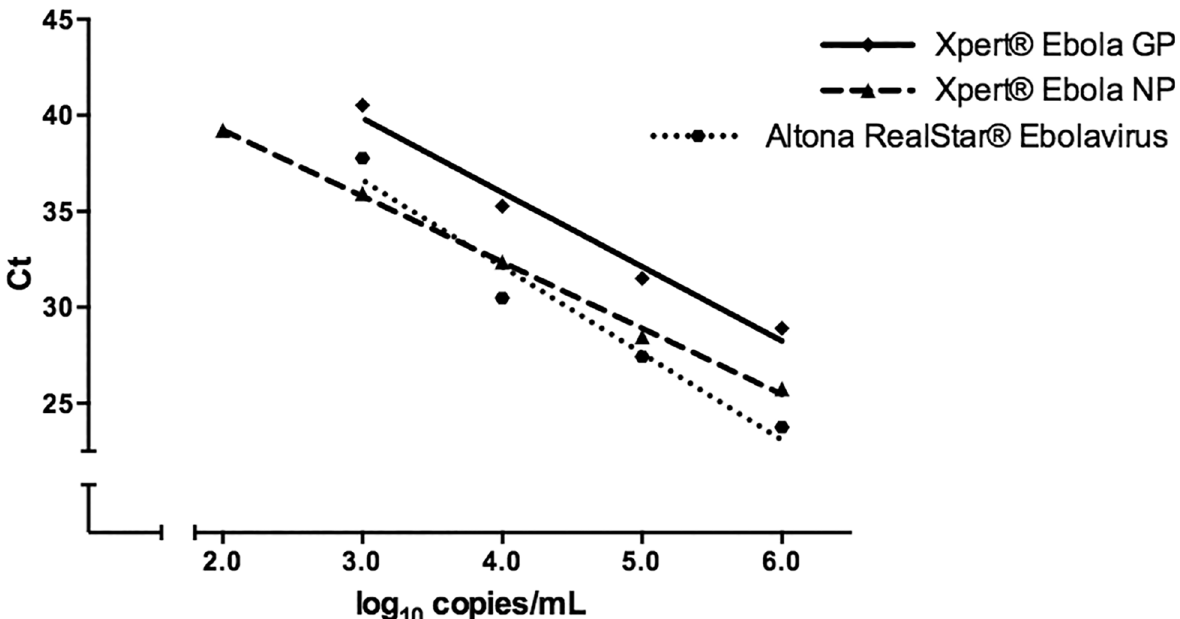
Fig 1. Linearity of the Xpert 1 Ebola Assay and Altona RealStar 1 Ebolavirus RT-PCR Kit 1.0. Serial dilutions of inactivated EBOV Yambuku-Mayinga was spiked into EDTA-whole blood and tested in triplicate. Linear regression lines are shown for the Xpert 1 Ebola nucleoprotein (NP) and glycoprotein (GP) targets (NP: y = -3.44x+46.11, R 2 = 0.98; GP: y = -3.87x+51.45, R 2 = 0.87), and Altona RealStar 1 Ebolavirus (y = -4.51x+50.17, R 2 =